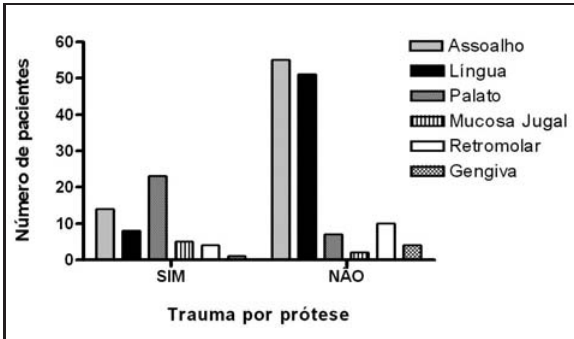
Figura 1 – Relatos de traumatismo crônico por prótese conforme a região